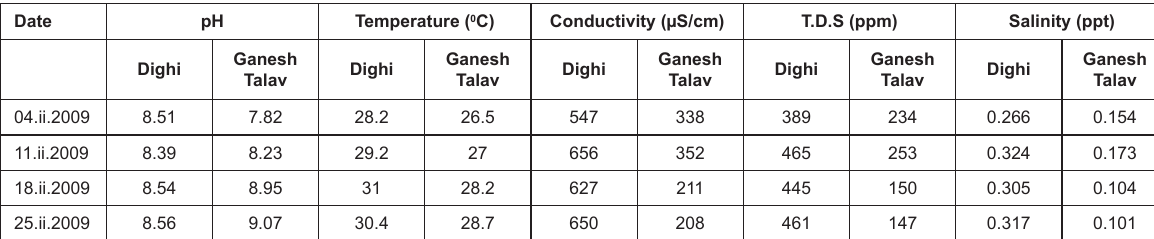
Table 1. Physico chemical properties of Ganesh Talav and Dighi Pond